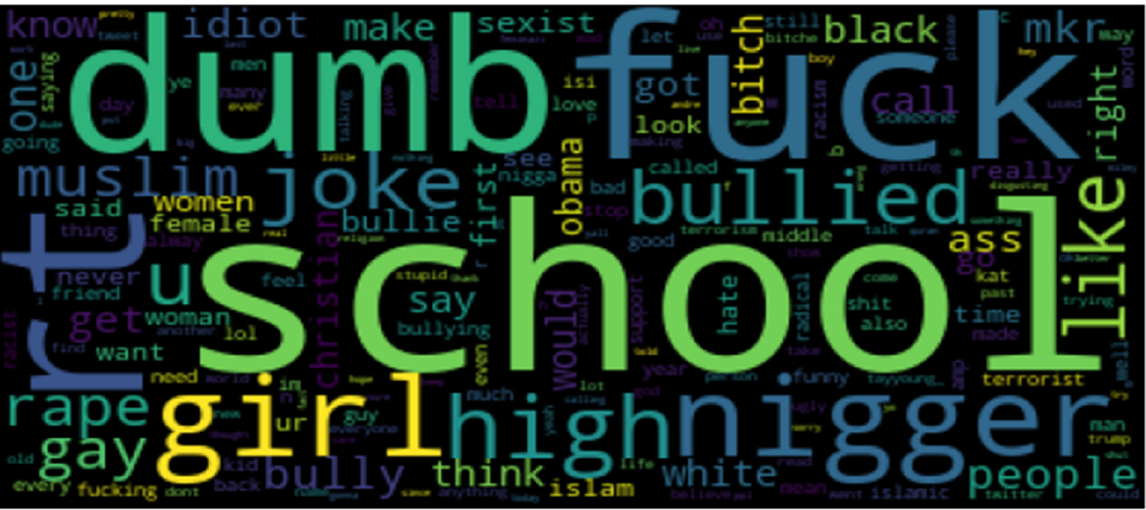
Figure 14. Word cloud for the multiclass tweets cyberbullying dataset.